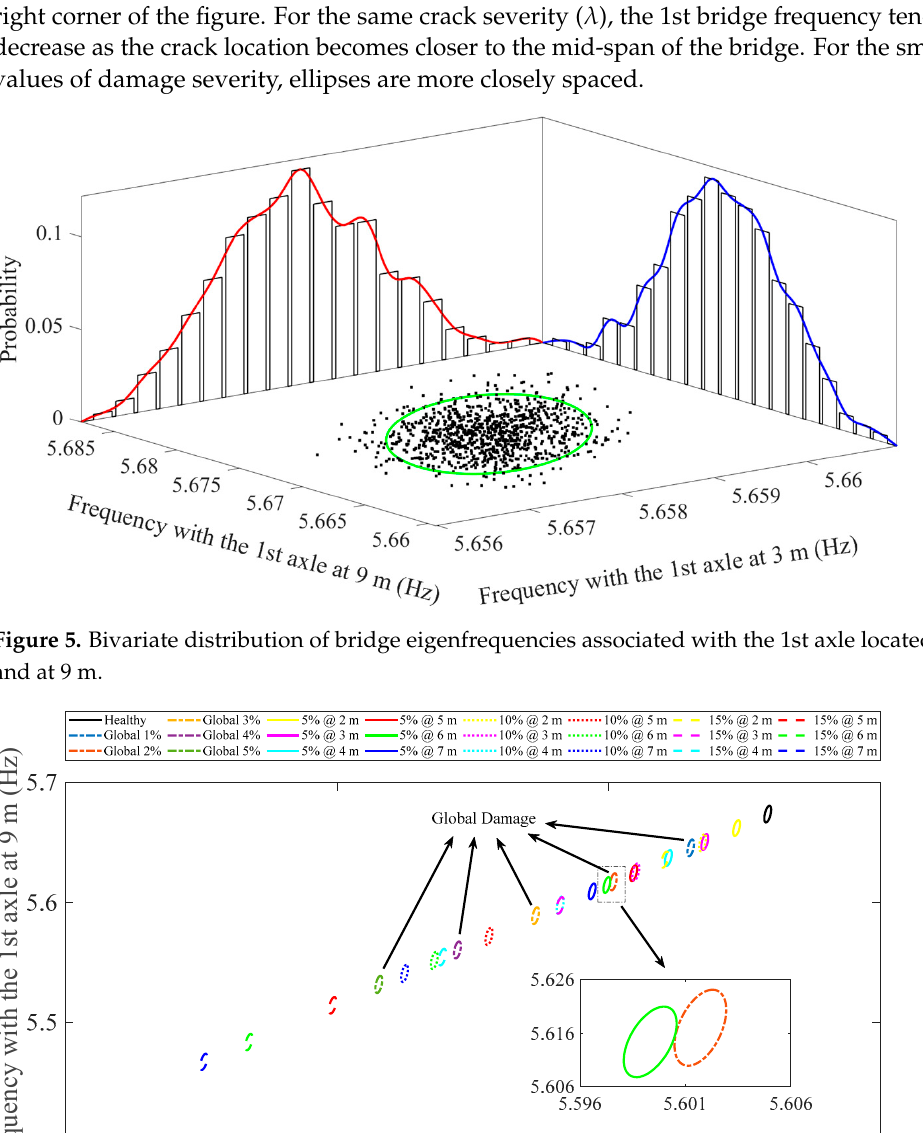
Figure 4. No. vehicles versus bridge eigenfrequencies associated with the 1st axle located at: ( a ) 3 m and ( b ) 9 m, from 1st support.